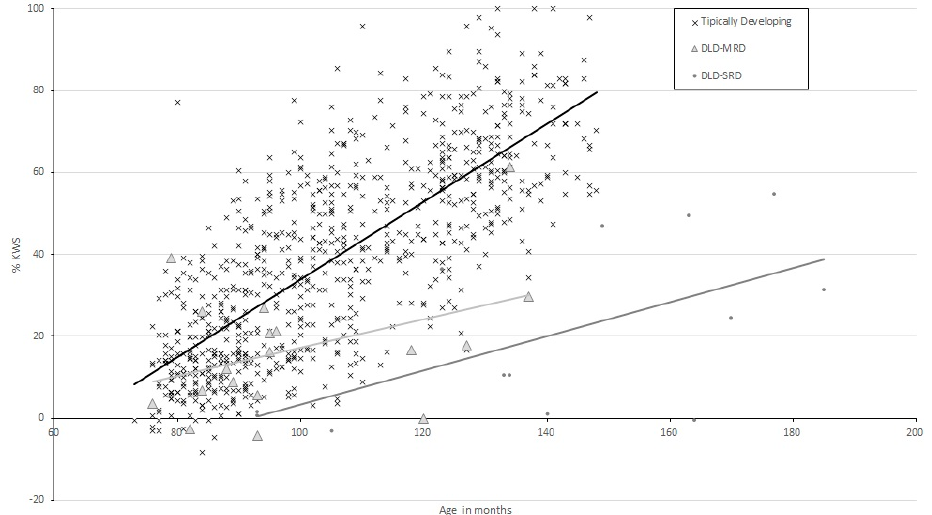
Figure 1. Scores for performance on the KWS test (in %) according to age in months by group (typically developing, DLD-MRD, and